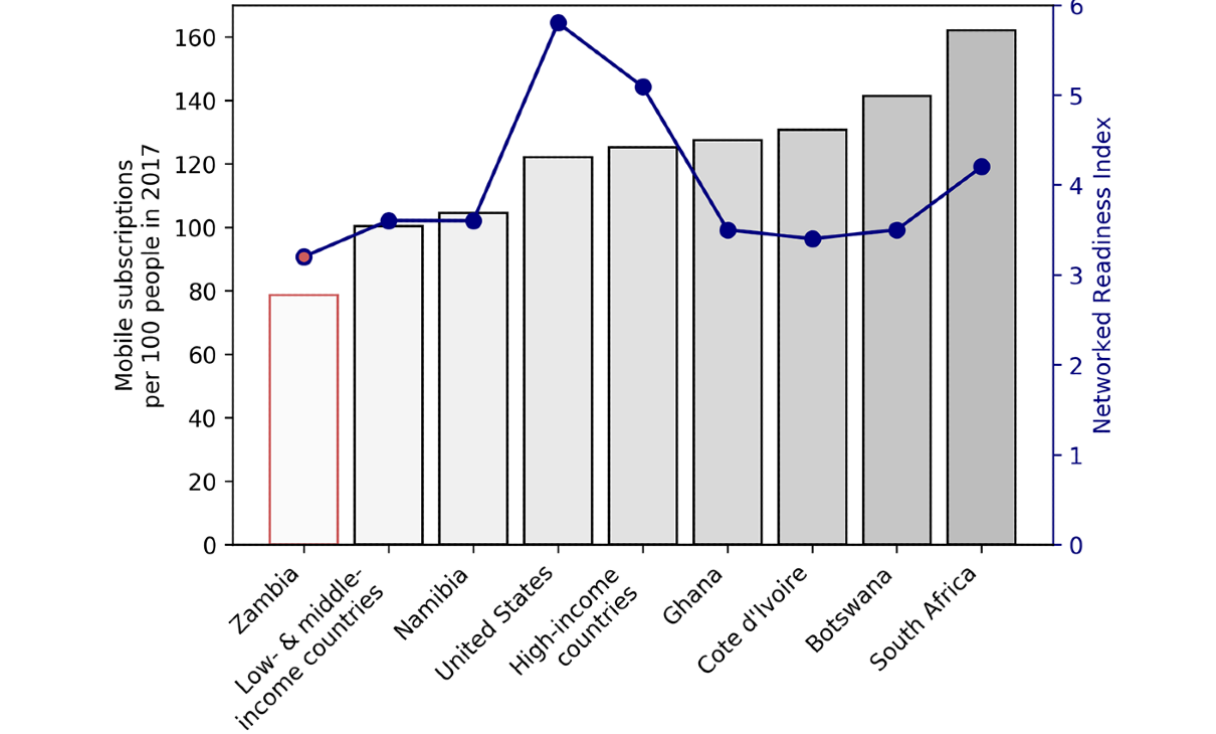
Figure 1. The number of mobile subscriptions per 100 people in 2017 and the World Economic Forum Networked Readiness Index (NRI) for several African nations, the United States, World Bank low- to middle-income countries, and World Bank high-income countries. Data for Zambia, the country where this study was performed, are emphasized in red. The NRI data for low- to middle-income countries and high-income countries are averages of the available NRIs for World Bank countries in each classification (several countries in each group do not have a listed